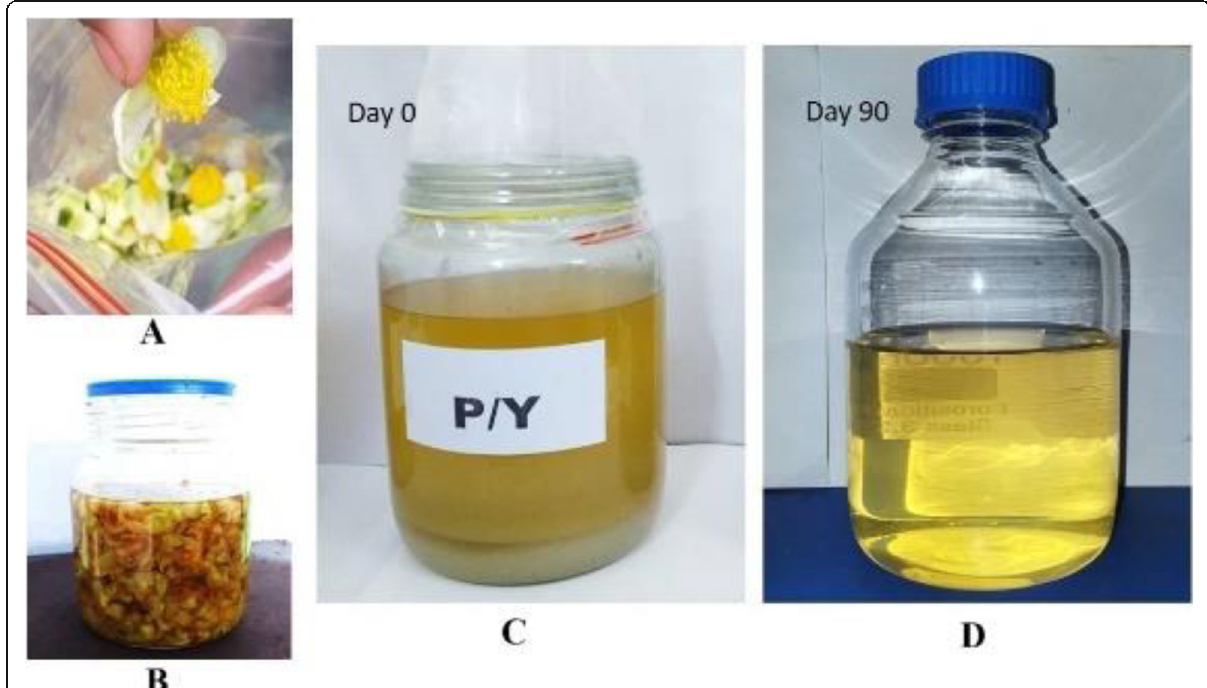
Fig. 1 Collection of tea petals, preparation of petal decoction and incubation. A Collection of tea petals, B Decoction of petals, C Fermented tea petal decoction broth at 0th day and D FTPD on 90th day of fermentation after